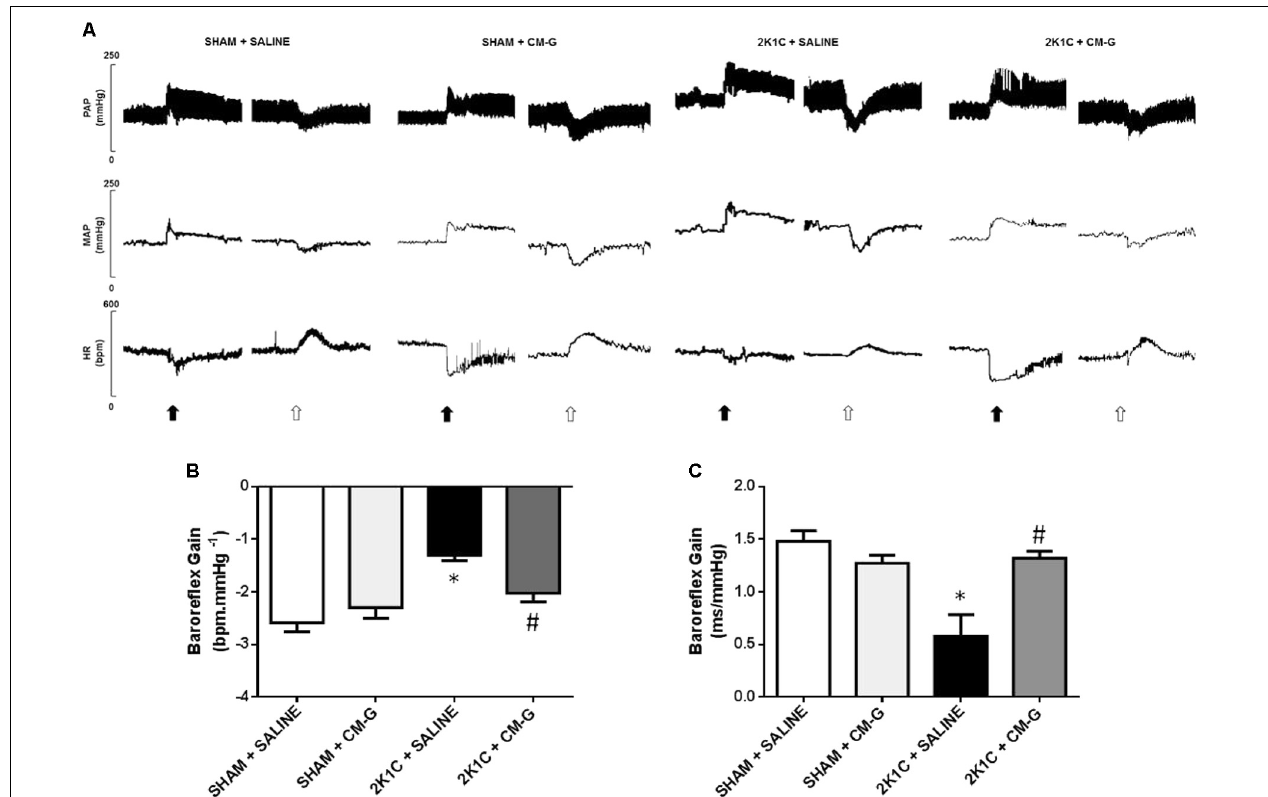
FIGURE 3 | Oral administration of carboxymethyl-glucan (CM-G) restores baroreflex sensitivity in renovascular hypertensive rats (A) Original tracings from one representative animal from each group (Sham + Saline, Sham + CM-G, 2K1C + Saline, 2K1C + CM-G) showing changes in pulse arterial pressure (PAP), mean arterial pressure (MAP) and heart rate (HR) in response to phenylephrine (8 µ g/Kg, i.v., black arrows) and sodium nitroprusside (25 µ g/Kg, i.v., open arrows). (B) Effects of oral administration of CM-G for 2 weeks on pharmacologically evoked baroreflex sensitivity. (C) Effects of oral administration of CM-G for 2 weeks on spontaneous baroreflex sensitivity. ∗ P < 0.05 2K1C + SALINE vs SHAM + SALINE; # P < 0.05 2K1C + CM-G vs 2 K1C + SALINE